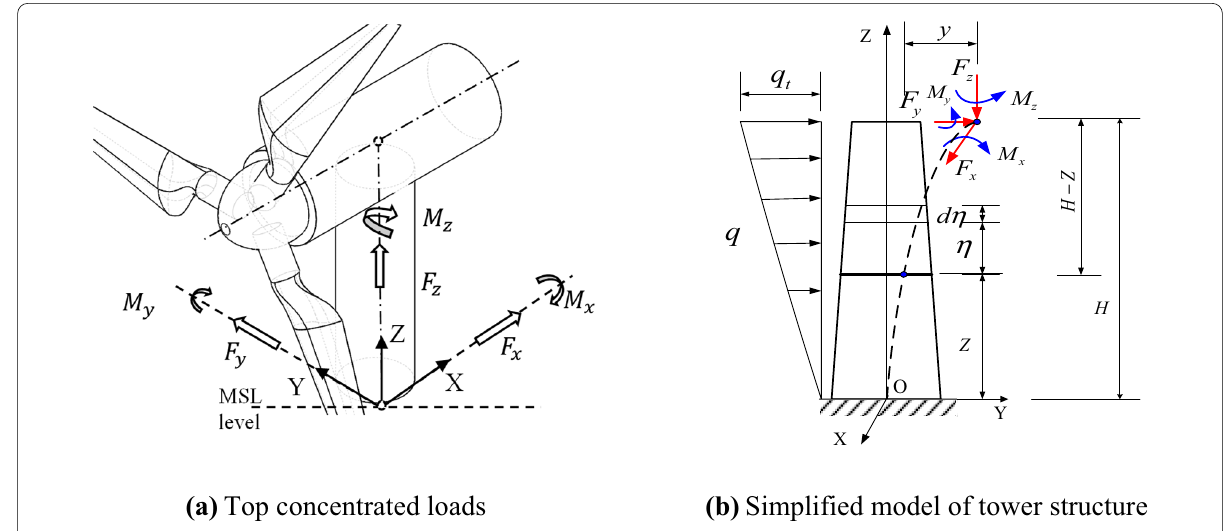
Fig. 3 Coordinate system of tower.